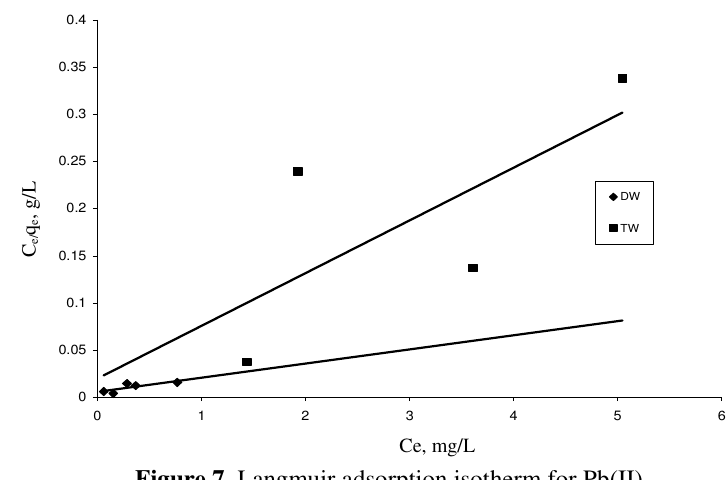
Figure 7 . Langmuir adsorption isotherm for Pb(II).